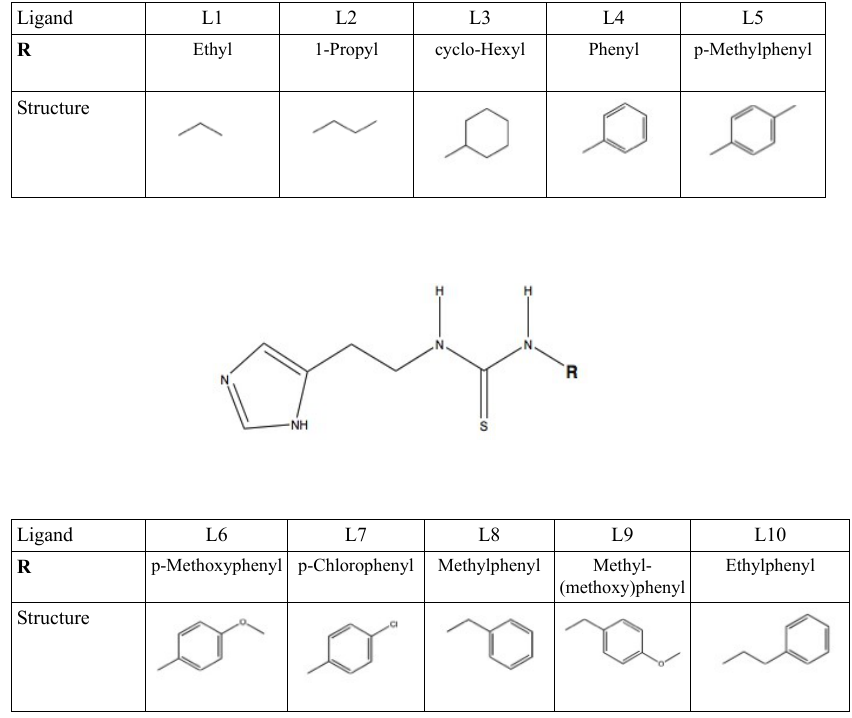
Figure 1. Set of thiourea-containing compounds used to develop a CYP 2D6 LIE model